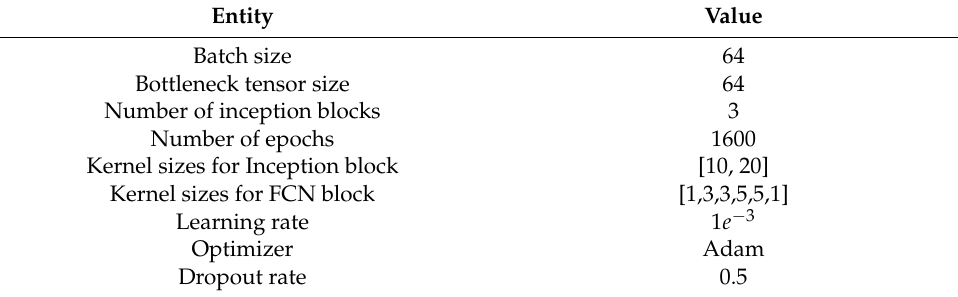
Table 1. Hyperparameters for